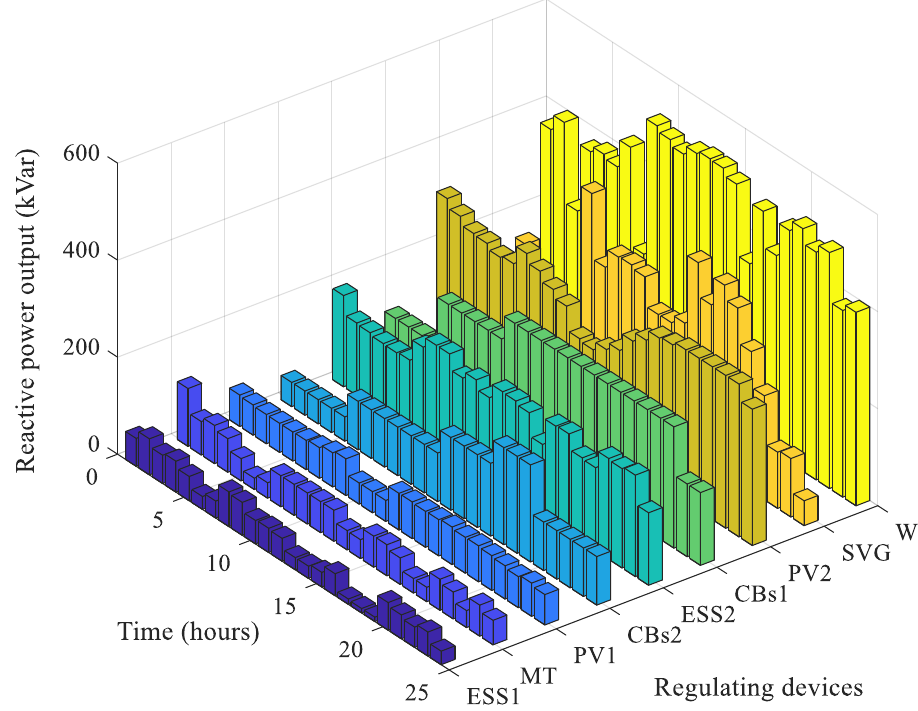
Figure 9. The optimization results of different reactive power-regulating devices.